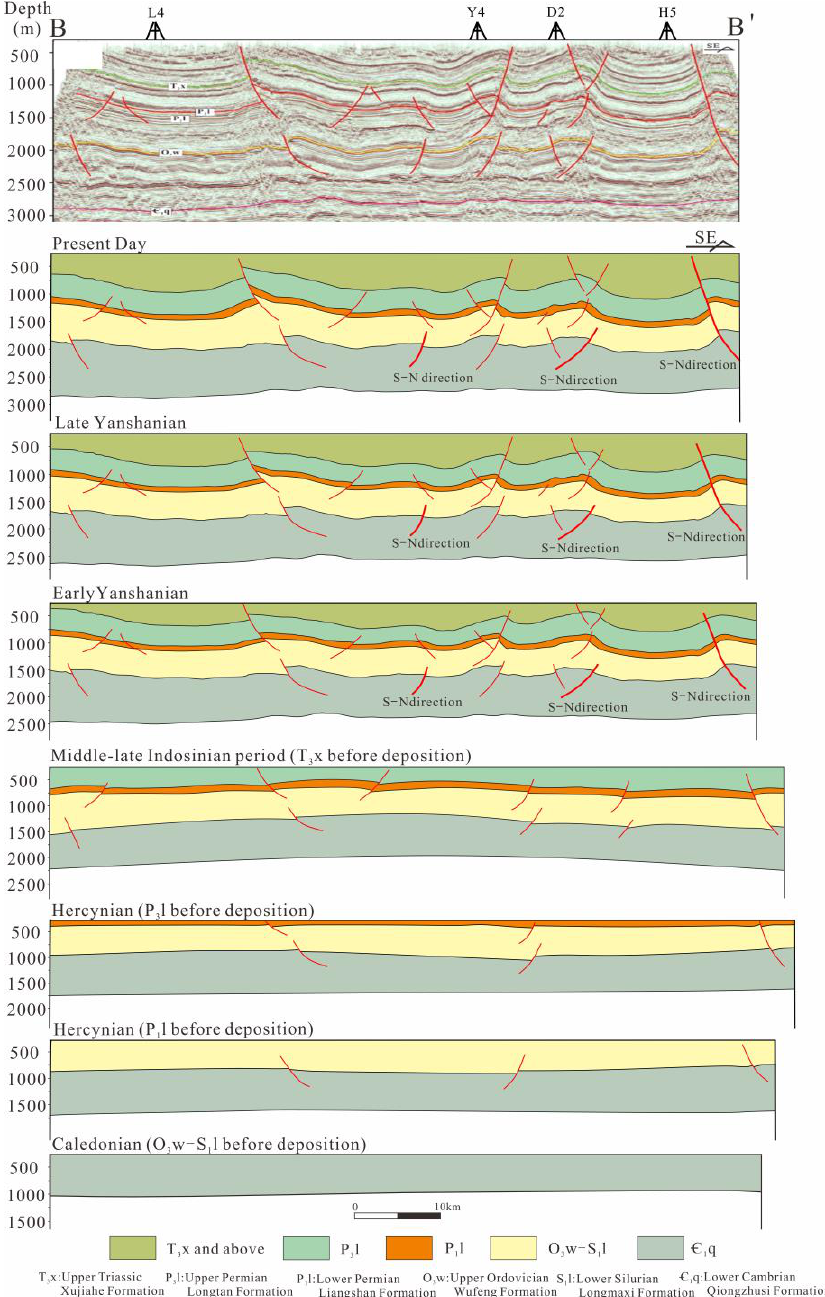
Figure 4. The tectonic evolution section of the Luzhou area (see Figure 1 BB ’ ).